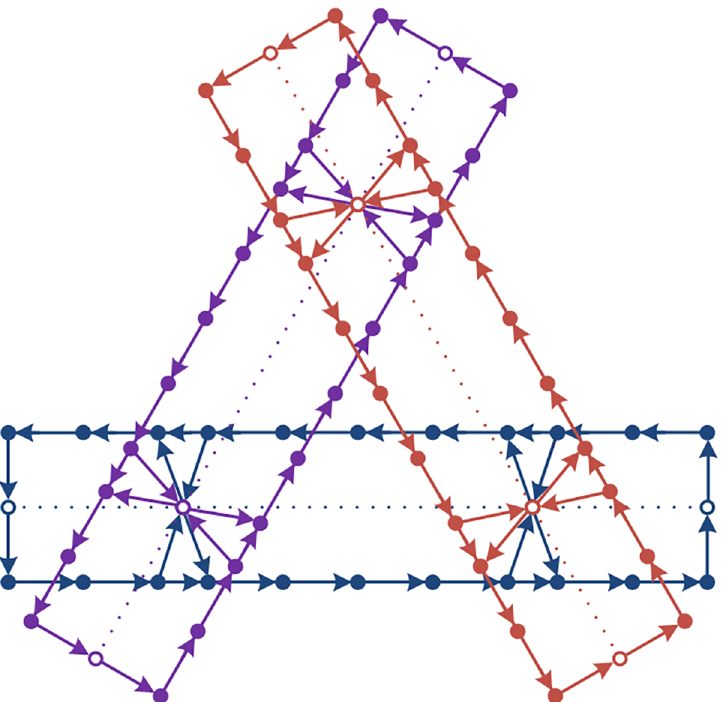
Fig 3. Illustration of the cell transmission